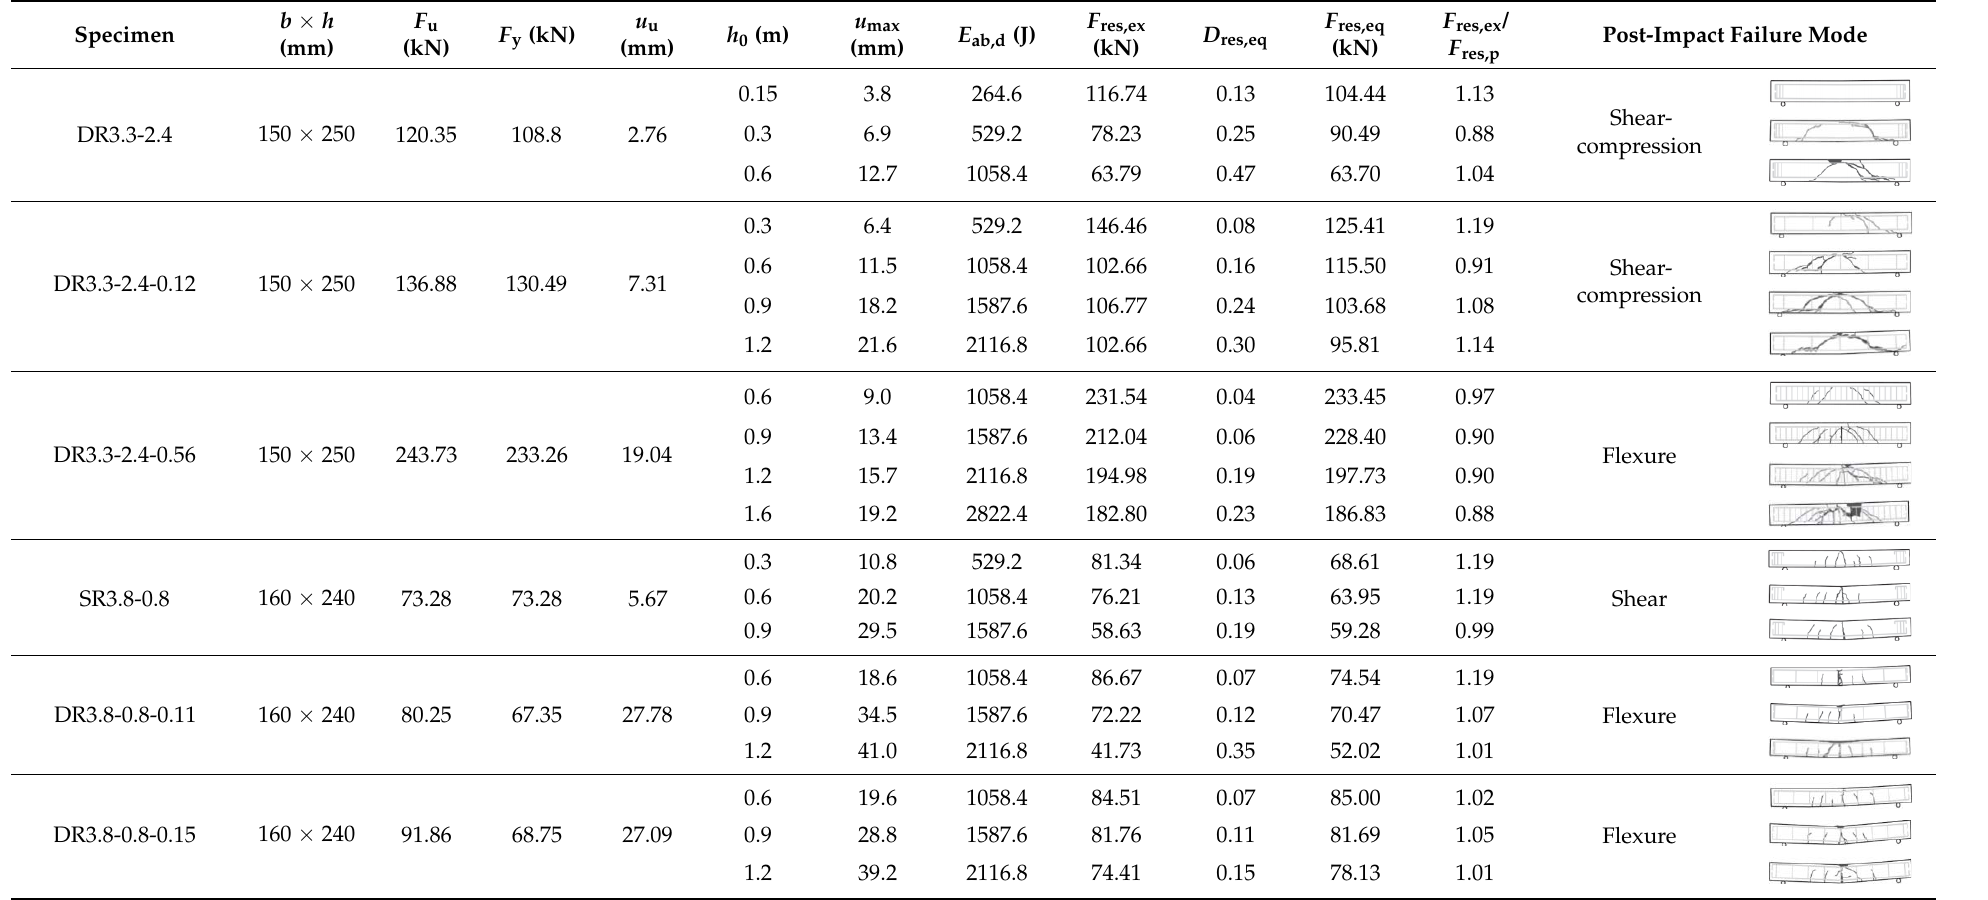
Table 5. Results of residual capacity tests in literature [10,26].